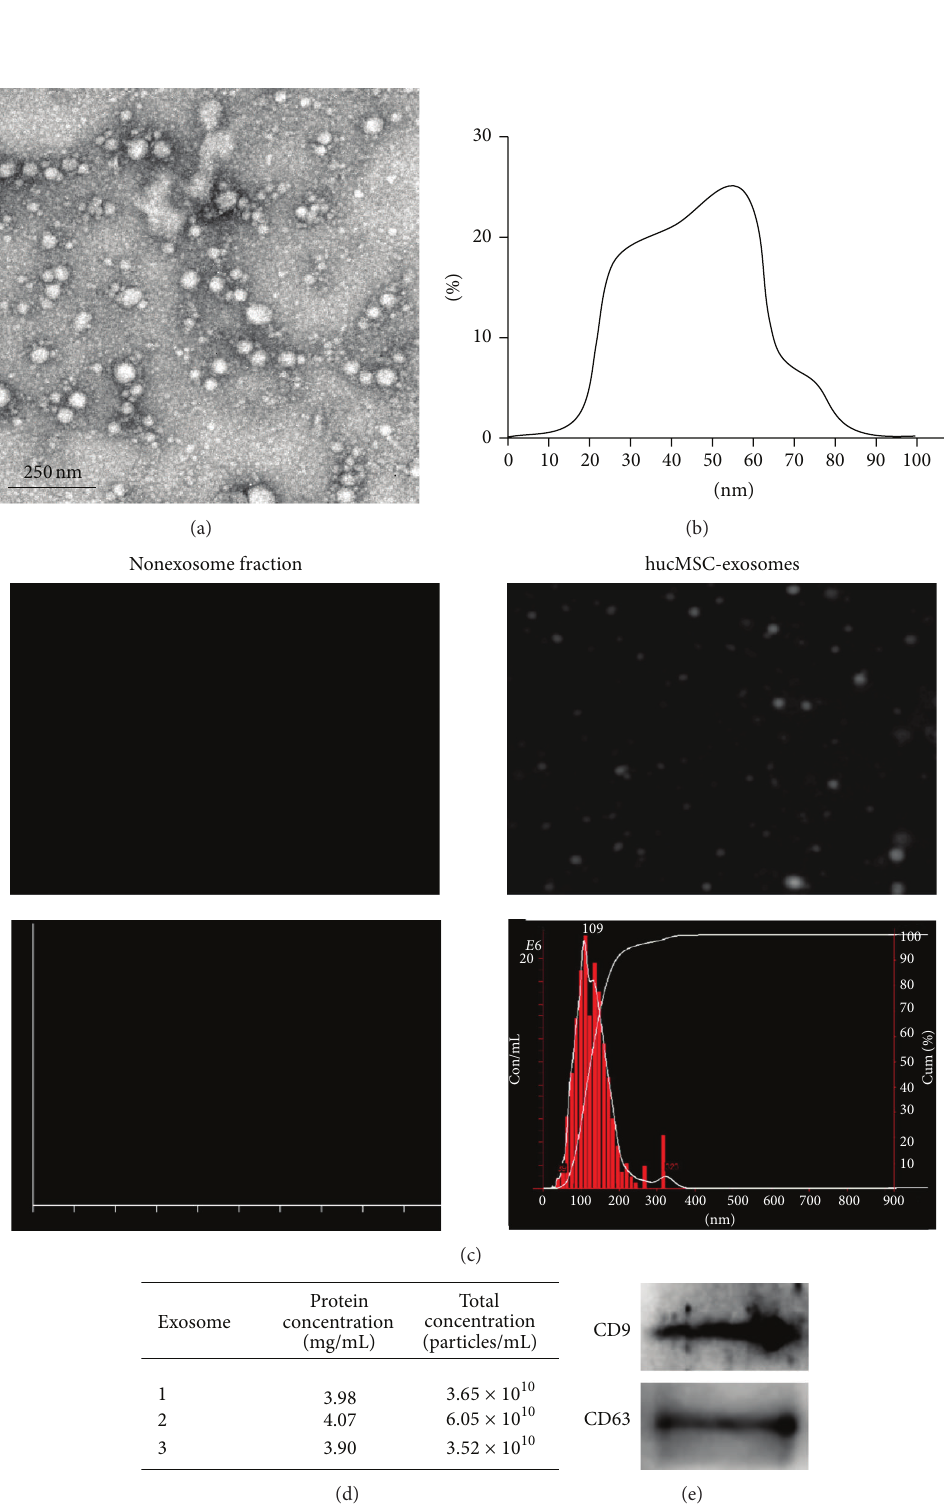
Figure 2: Identification of exosomes derived from hucMSC. Transmission electron photomicrograph of hucMSC-exosomes (a). Scale bar = 250 nm. Diameter ranges of hucMSC-exosomes under transmission electron microscopy (b). NTA of nonexosome fraction and hucMSC- exosomes (c). The protein concentration and particle concentration of hucMSC-exosomes in different batches (d). CD9 and CD63 expression in hucMSC-exosomes detected by western blot